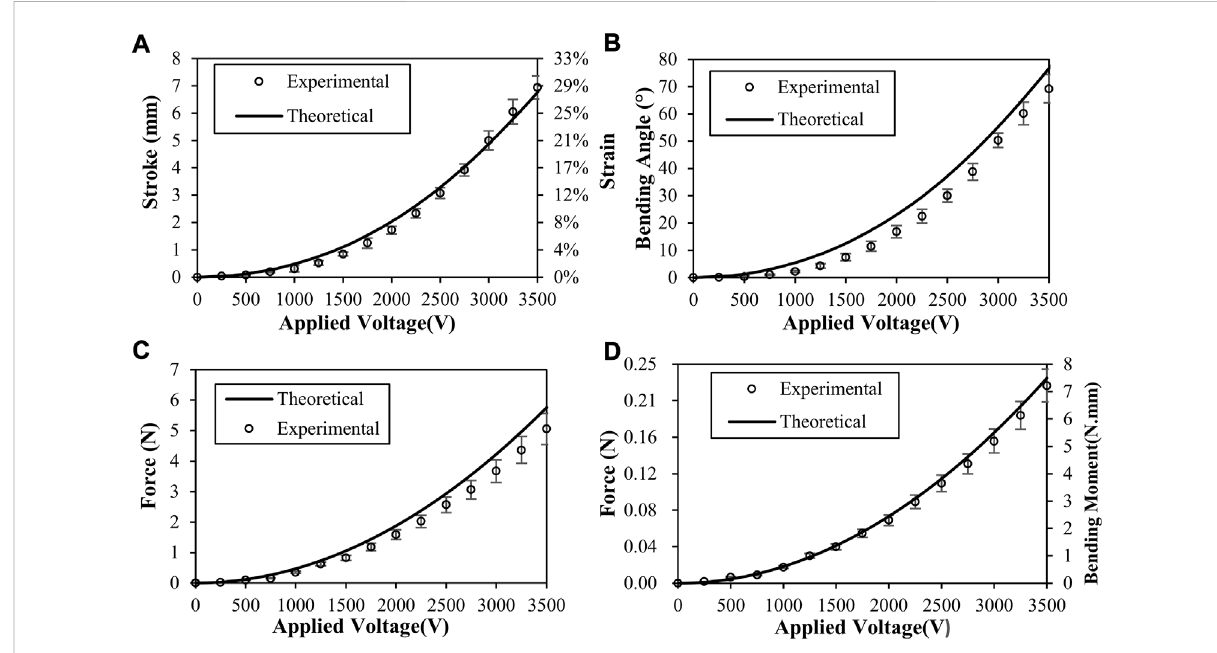
FIGURE 11 (A) Stroke/strain of linear-type spring-roll DE actuator versus applied voltage; (B) Angulation of bending-type spring-roll DE actuator versus applied voltage; (C) Output force of linear-type spring-roll DE actuator versus applied voltage; (D) Lateral blocking force/bending moment versus applied voltage for bending-type spring-roll DE